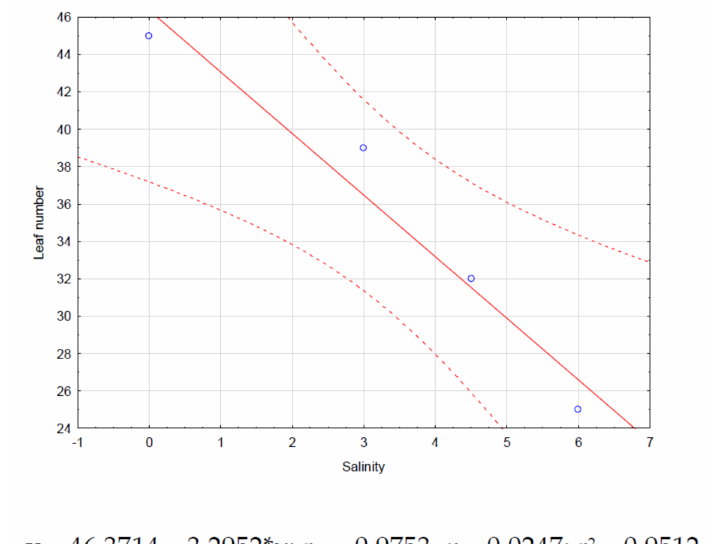
Figure 3. Zinnia correlation between salinity and leaf number.